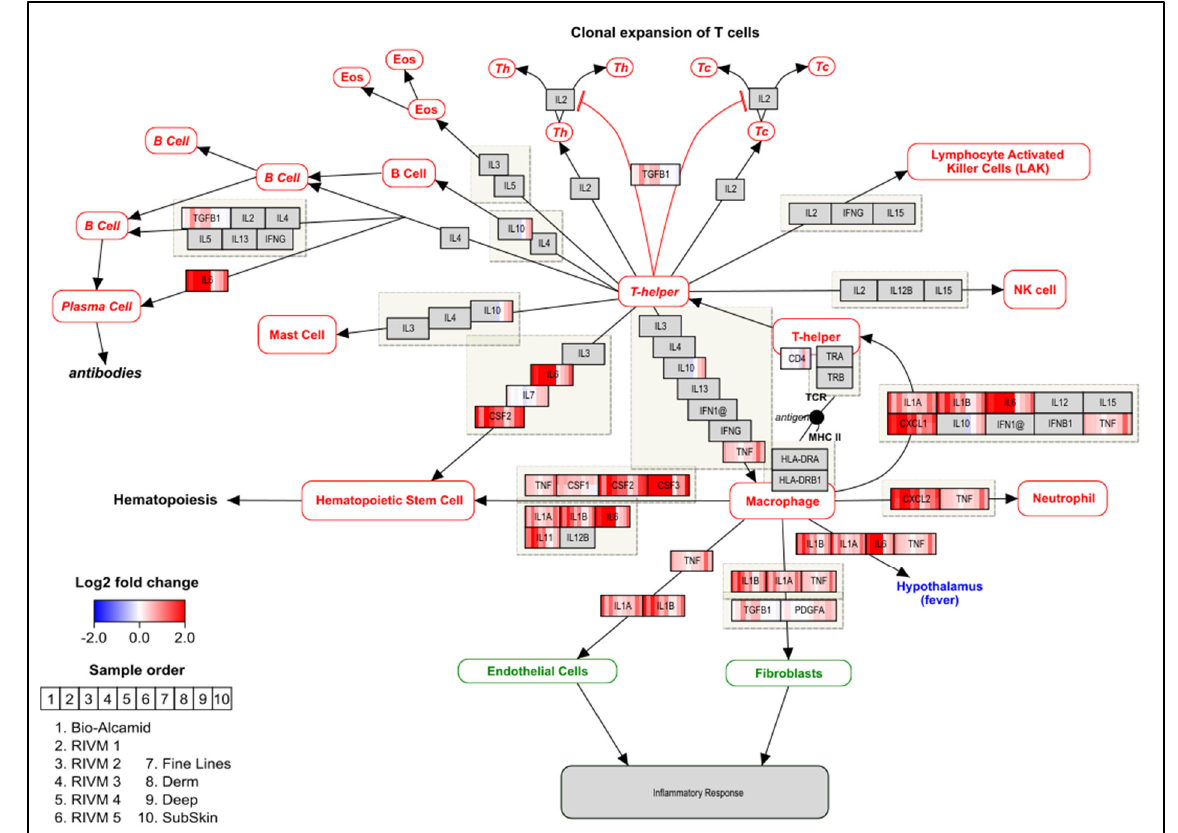
Figure 1. Visualization of gene expression changes for the Phenion ® Full-Thickness Skin model exposed to Bio-Alcamid ® , RIVM preparations and Perfectha ® fillers on the “Cytokines and inflamma- tory response pathway”.